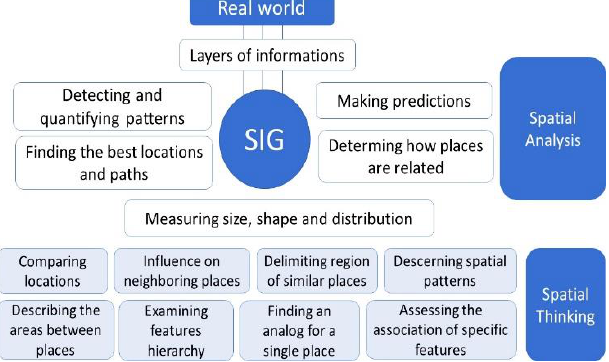
Figure 1 . Relationship between GIS and spatial analysis and spatial thinking. Author’s work based